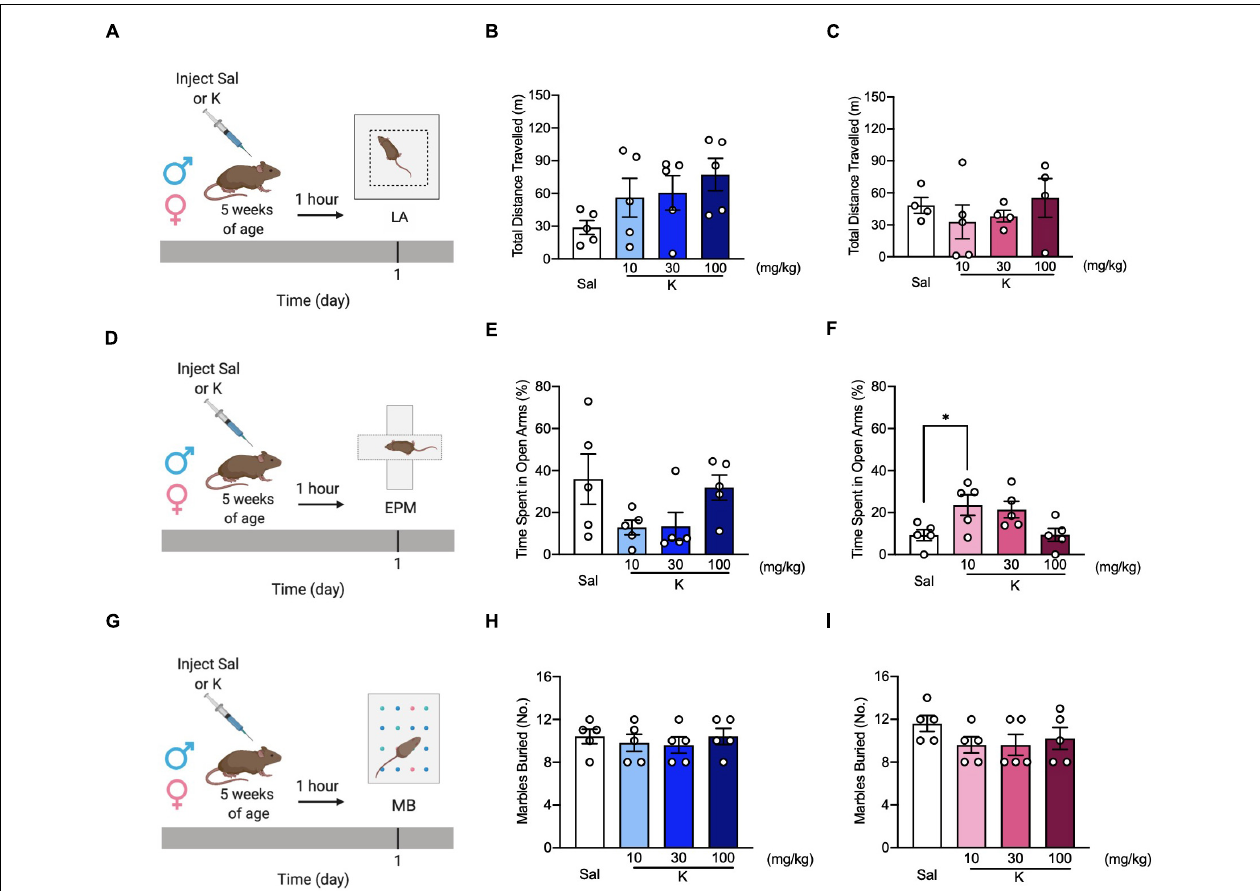
FIGURE 2 | ( R,S )-ketamine decreases avoidance behavior without affecting locomotor activity and perseverative behavior in adolescent mice. (A) Experimental design. (B,C) Male and female 5-week-old mice showed comparable distance traveled in the LA. (D) Experimental design. (E) All groups of 5-week-old male mice spent a similar time in the open arms of the EPM. (F) Five-week-old female mice administered ( R,S )-ketamine (10 mg/kg) spent significantly more time in the open arms of the EPM compared to saline mice. (G) Experimental design. (H,I) Male and female of 5-week-old mice buried a comparable number of marbles. ( n = 4–5 mice per group). Error bars represent ± SEM. ∗ p < 0.05. Sal, saline; K, ( R,S )-ketamine; LA, locomotor activity test; EPM, elevated plus maze; MB, marble burying; mg, milligram; kg, kilogram; m,